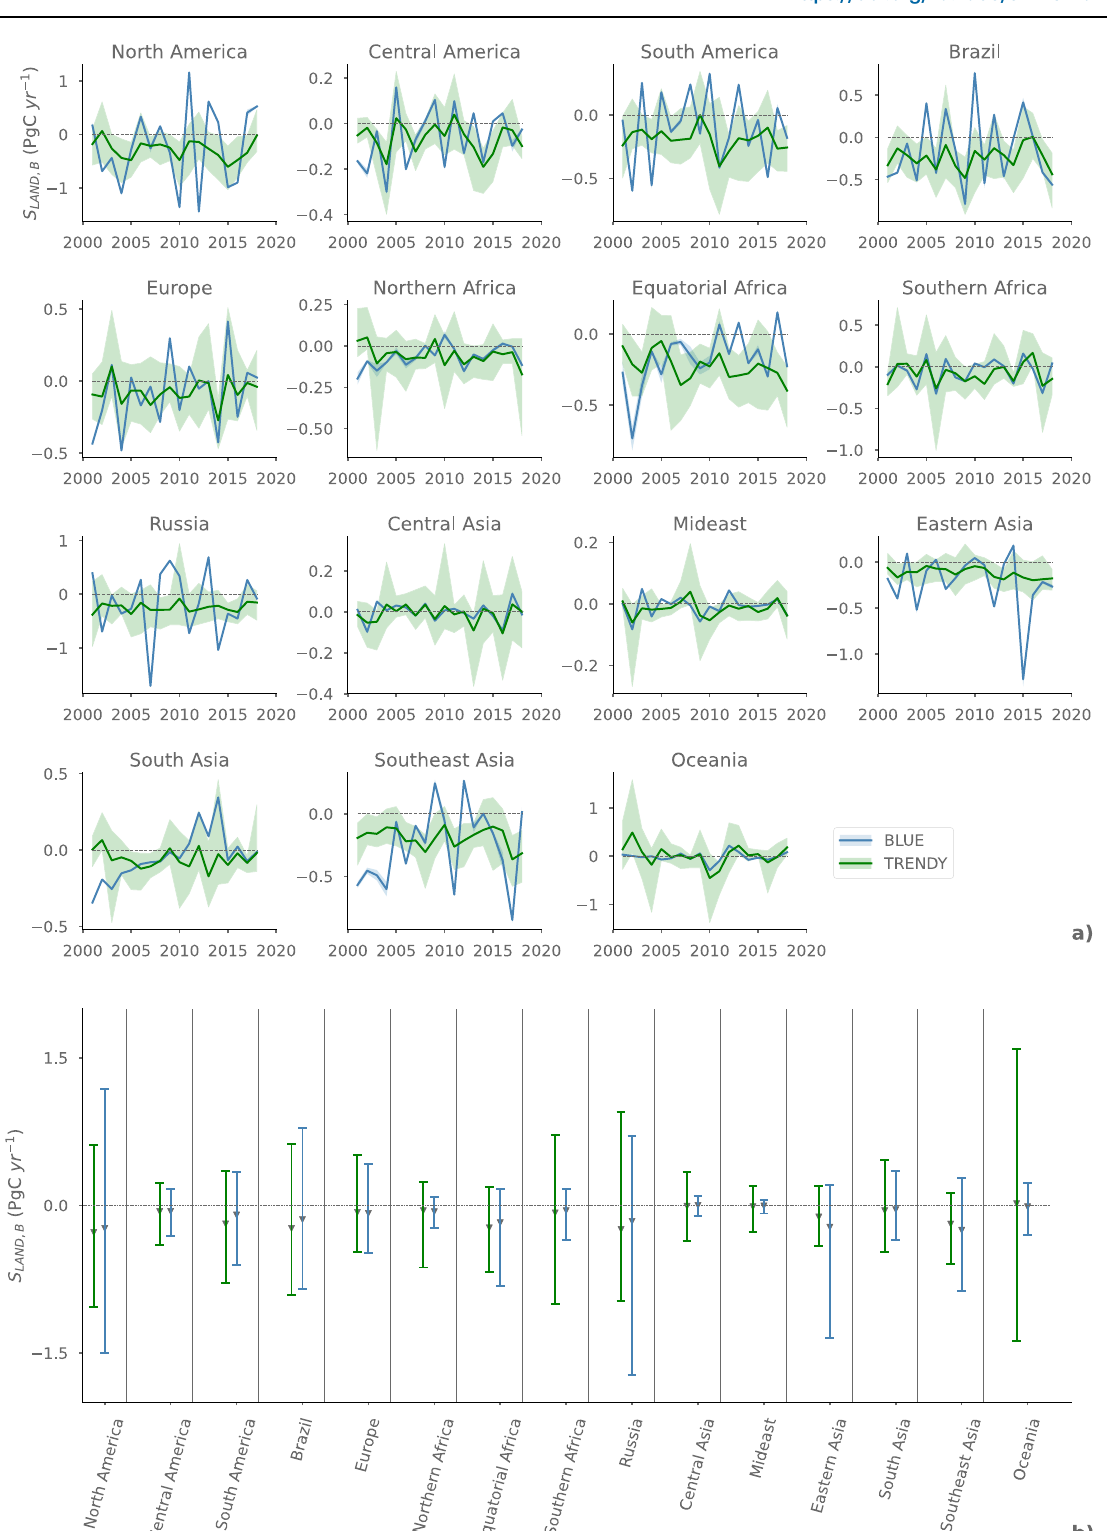
multi-model range and the range between the BLUE threshold approaches are shown as shaded areas. The variability of S LAND, B , averaged over each region, is presented in b : The whiskers extend from the multi-model minimum to the multi- model maximum between 2001 and 2018, and the multi-model average over all years is shown as gray triangles. Uptakes of carbon by vegetation are negative (sinks), whereas releases of carbon by vegetation are positive